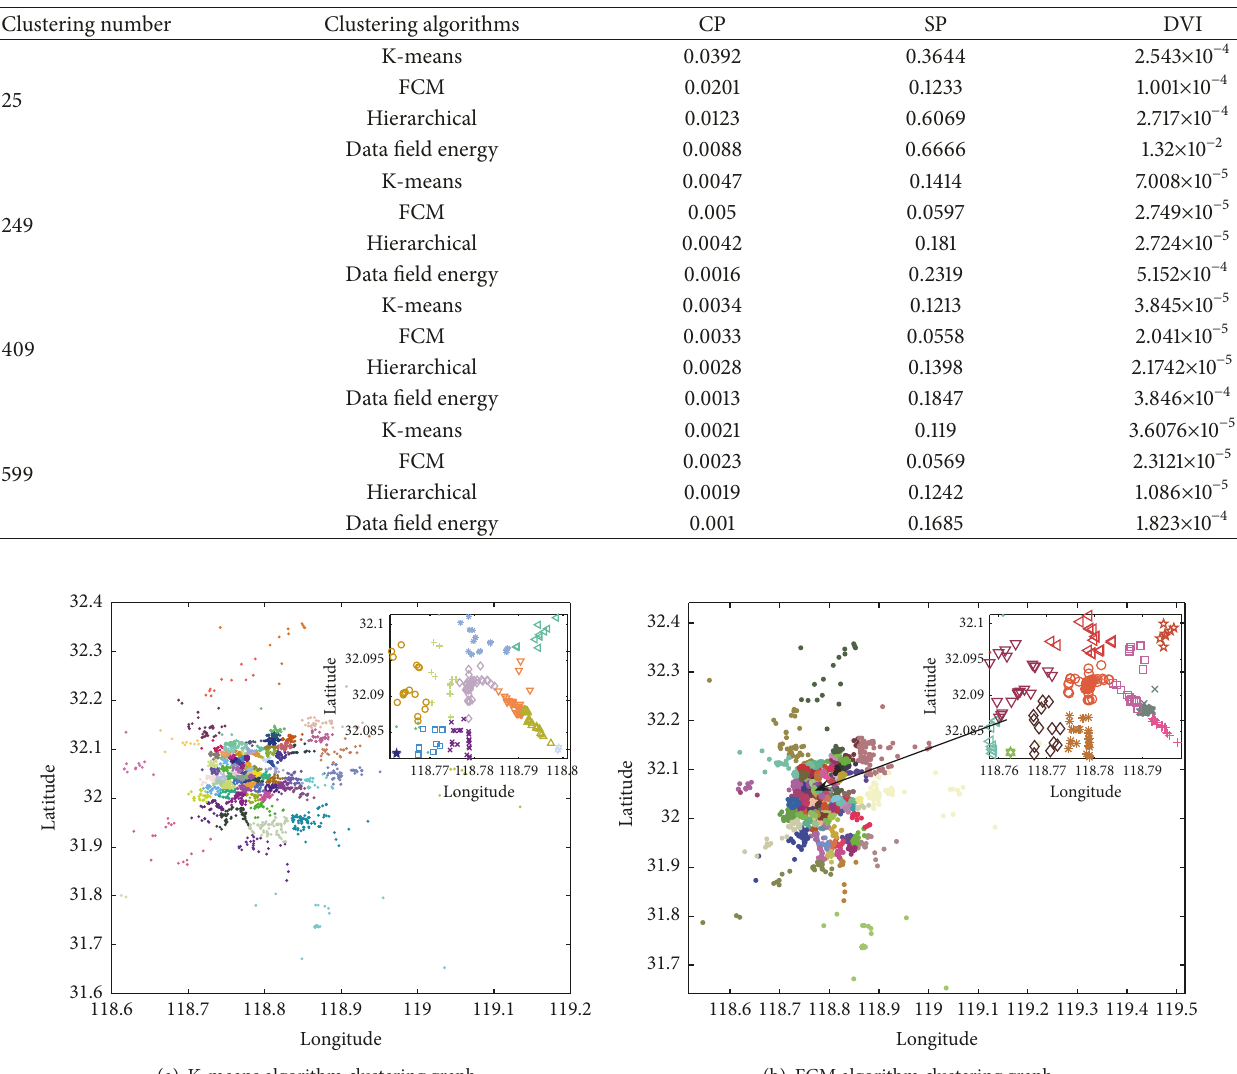
Table 1: Comparison table of clustering effect evaluation index of each clustering algorithm.